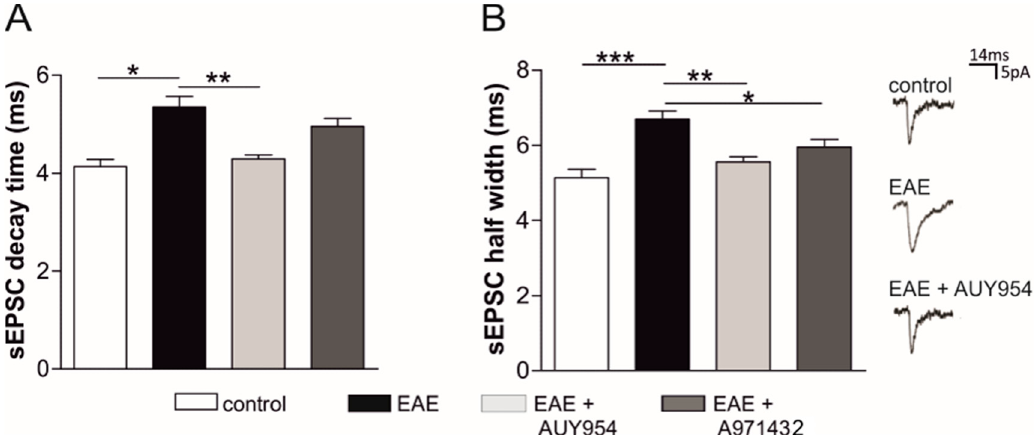
Figure 6. Ex vivo treatment with S1P 1 and S1P 5 agonists ameliorates glutamatergic dysfunction in EAE striatal slices. Whole-cell patch clamp recordings from MSNs show that the kinetics of the glutamatergic currents, decay time ( A ) and half width ( B ), were increased in EAE striatum and were completely rescued after 2 h incubation with AUY954 (300 nM, S1P 1 specific). A971432 (200 nM, S1P5 specific) only partially rescued the EAE sEPSC kinetics. On the right, representative peaks of electrophysiological recordings in the di ff erent experimental conditions are shown. Data are presented as mean ± SEM. ANOVA, * p < 0.05; ** p < 0.01; *** p < 0.001.